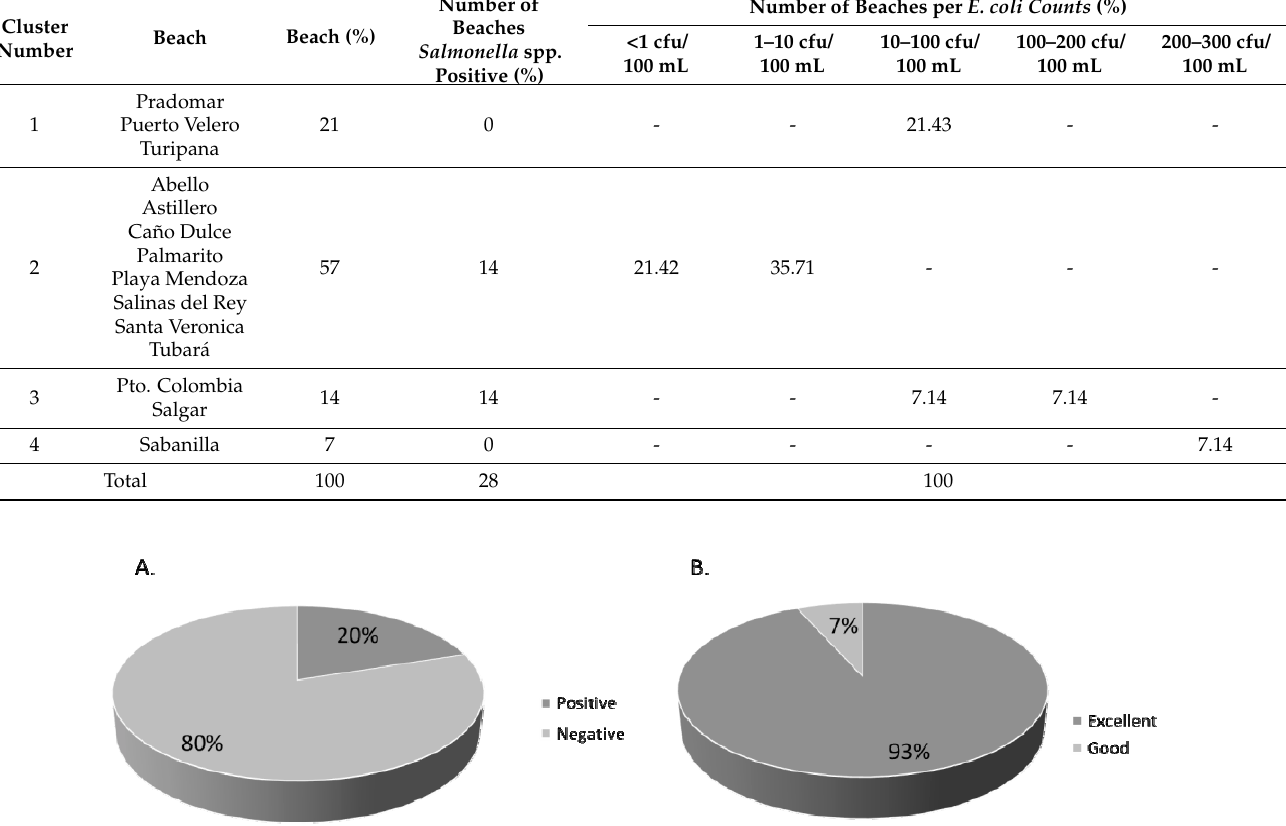
Table 2. Salmonella spp. and E. coli counts according to the four different clusters in which beaches were grouped. Cluster Number